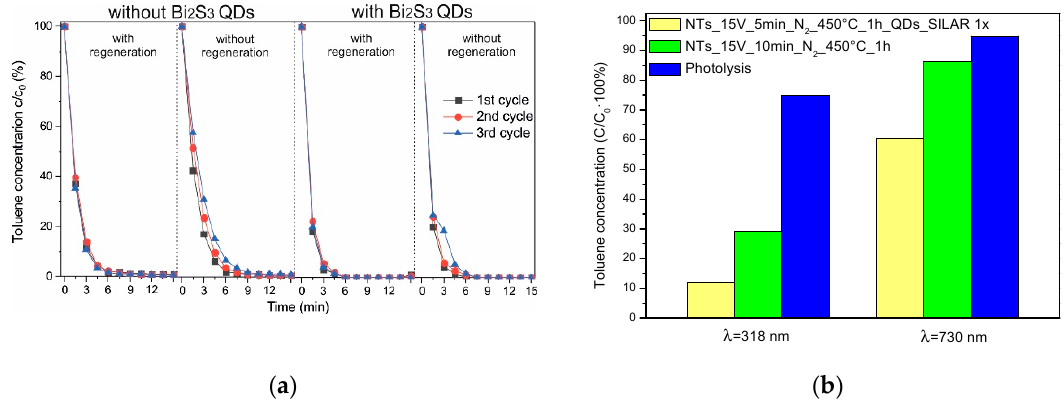
Figure 6. Photocatalytic activity of selected samples, shown as toluene degradation: ( a ) photocatalyst stability during three irradiation cycles for NTs_15 V_5 min_N 2 _450 °C_1 h and NTs_15 V_5 min_N 2 _450 °C_1 h_QDs_SILAR 1x. ( b ) Efficiency of toluene removal over Ta 2 O 5 nanotube arrays (NTs) and bismuth sulfide (Bi 2 S 3 ) quantum dots (QDs)/Tantalum pentoxide (Ta 2 O 5 ) NTs samples and in the blank tests (toluene photolysis in the absence of a photocatalyst) under monochromatic light— 318 nm and 730 nm .